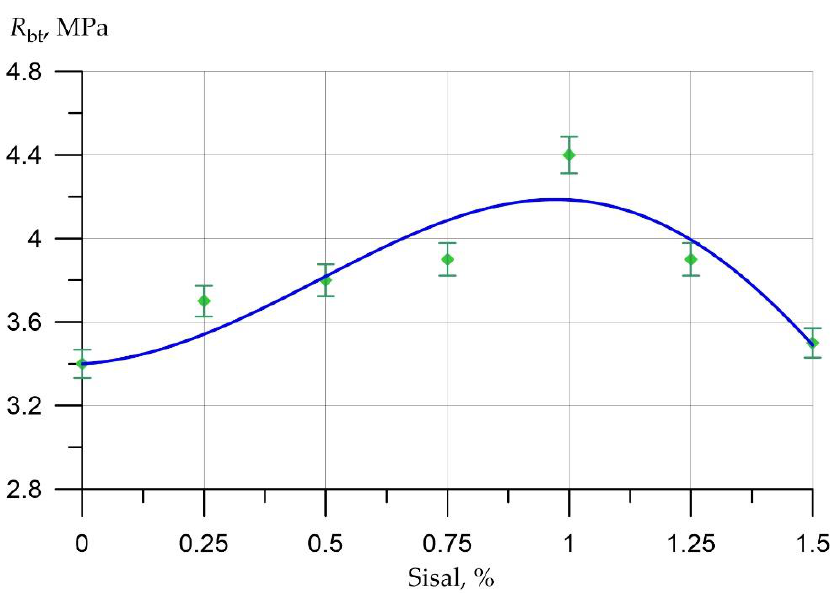
Figure 7. Results of experimental studies of tensile strength in bending R btb of concrete samples in the form of prisms with various percentages of reinforcement with sisal fibers.